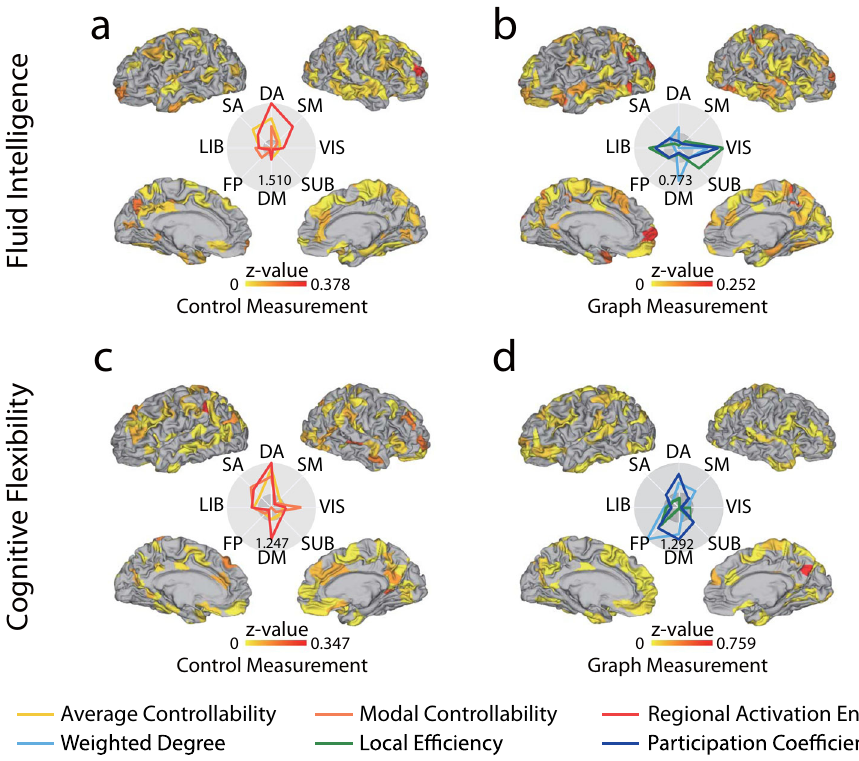
Fig. 4 Prediction of scores in the behavioral tasks. The z-value is the Fisher z-value of the correlation between the observed and predicted scores. a The control theoretical measurements of the dorsal attention network contribute most in the prediction model. The z-value measures the decline of the model performance when the measurement values on the corresponding area are removed from the input feature vector. b The graph-theoretical measurement in the visual system contributes most in the prediction model. c The control theoretical measurements of the dorsal attention and default mode networks contribute positively high in the prediction model. d The graph-theoretical measurement of the dorsal attention, default mode, and fronto-parietal networks contributes positively high in the prediction t = 4.84, p = 5.63e − 5, n = 865), graph measurements (Fig. 5c, Combination vs. Control: t = 5.49, p = 6.04e − 6, n = 865; Combina- tion vs. Graph: t = 1.85, p = 3.81e − 2, n = 865), or their combination (Fig. 5d, Combination vs. Control: t = 7.79, p = 2.31e − 9, n = 865; Combination vs. Graph: t = 5.74, p = 9.35e − 7, n = 865). The